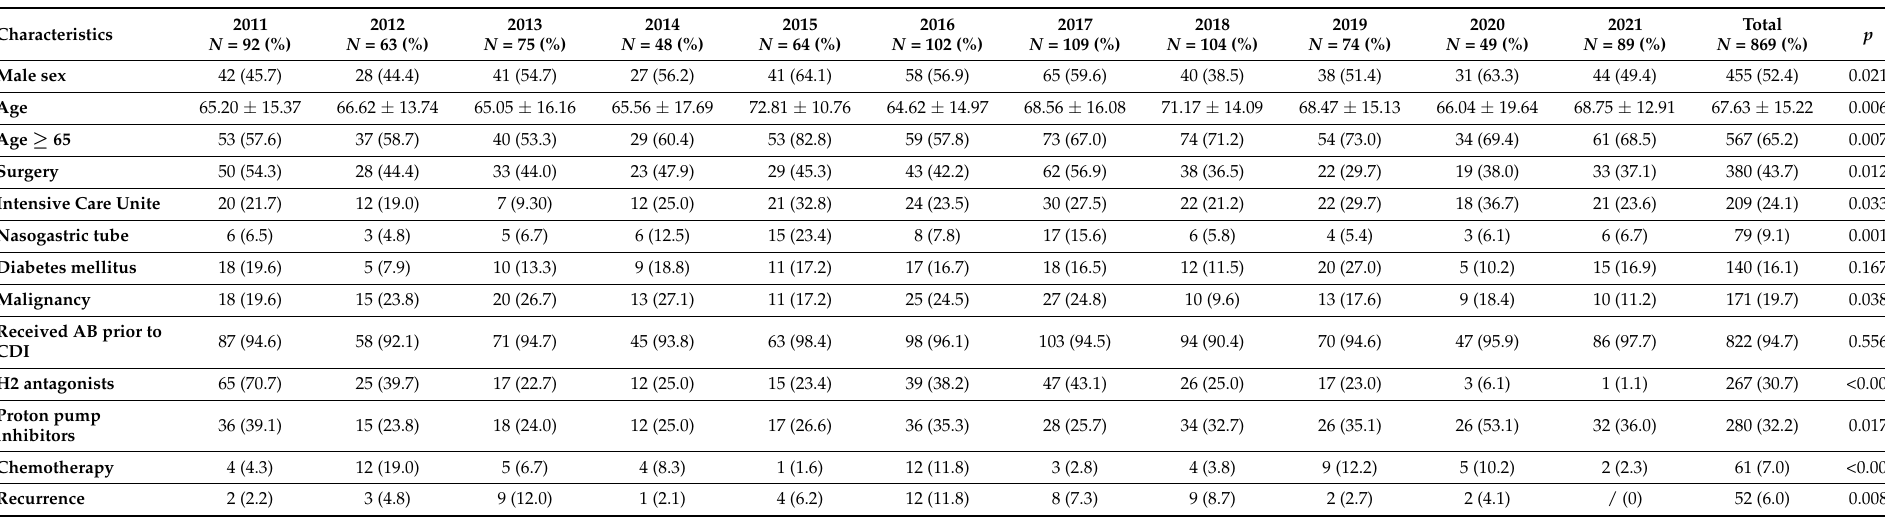
Table 1. Characteristics of 869 patients with hospital-acquired Clostridioides difficile infection over 11-year period (2011–2021). CDI— Clostridioides difficile infection; AB-antibiotics; absolute number with percent or mean with standard deviation.